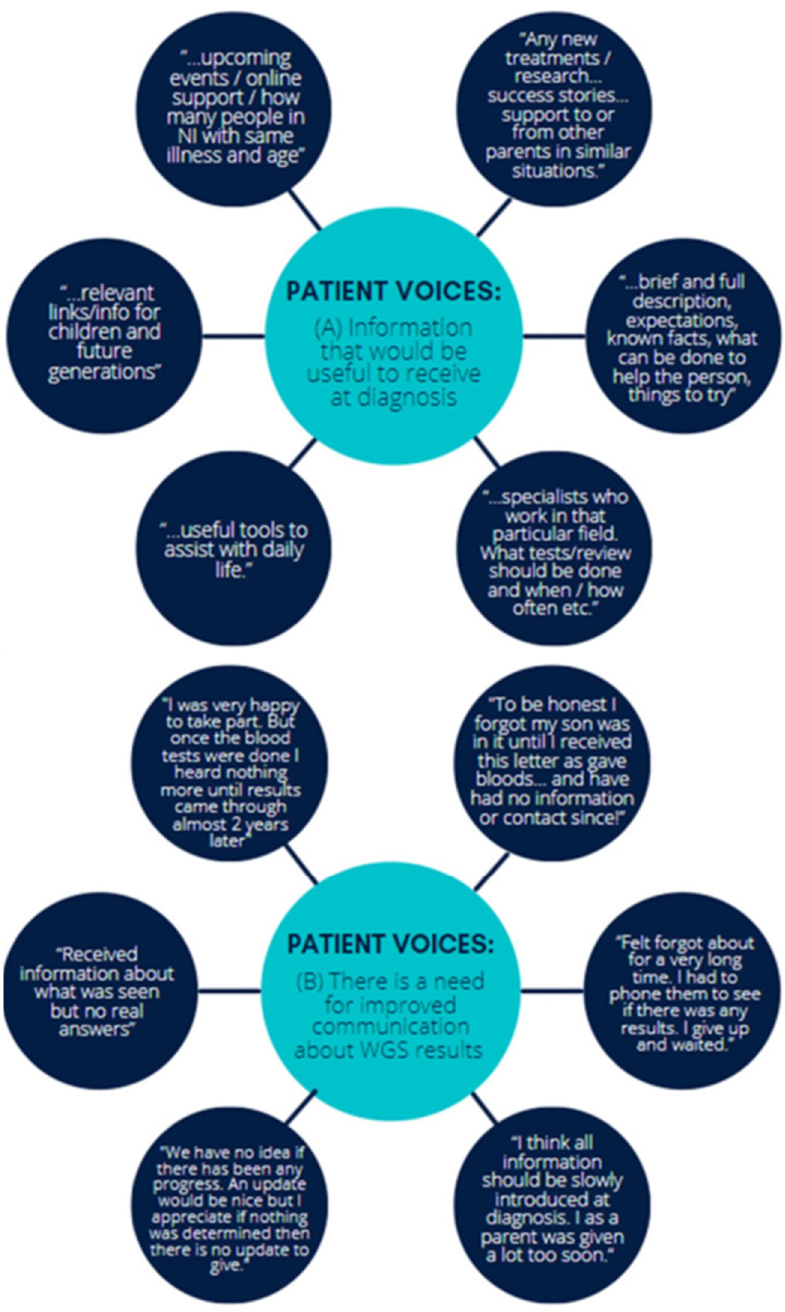
Figure 3. Patient voices about ( A ) what information would be useful to receive at diagnosis and ( B ) the need for improved communication regarding WGS results.